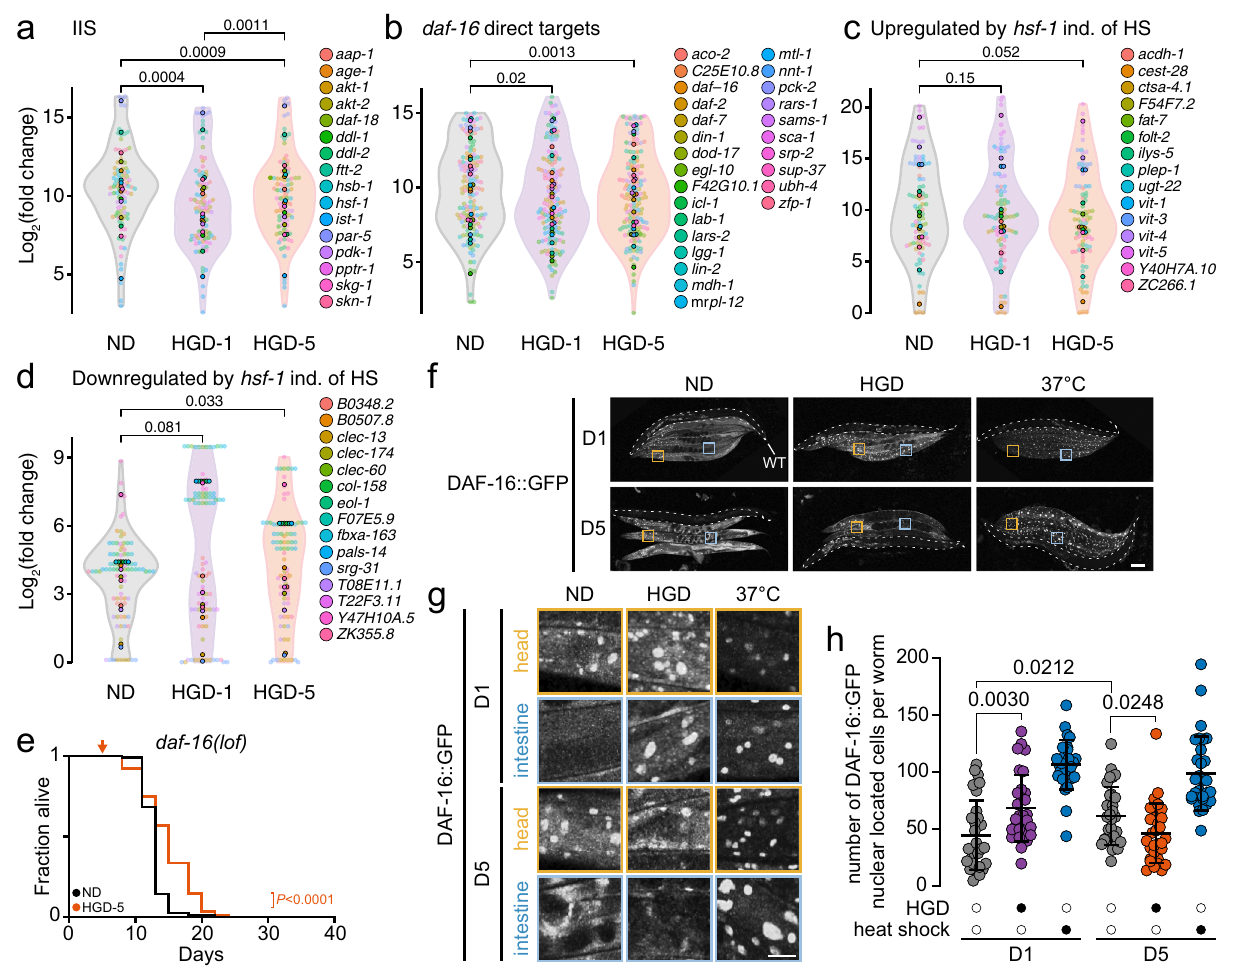
Fig. 5 | Glucose extends lifespan in aged worms independently of the DAF-16 (FOXO). Differentially regulated genes downstream of the insulin/insulin-like growthfactorsignalling(IIS)( a ),daf-16( b ),hsf-1independently(ind.)ofheatshock (HS)( c , d ) in animals fed on the normal diet (ND) or high-glucose diet (HGD) from 5-day old (HGD-5). e Lifespan assays of daf-16(lof) animals fed on the ND or HGD-5 (ND, n =502; HGD-5, n =536 including biological replicates). f , g Representative images of DAF-16::GFP localisation in 1- (D1) and 5-day old (D5) worms on 16h ND,